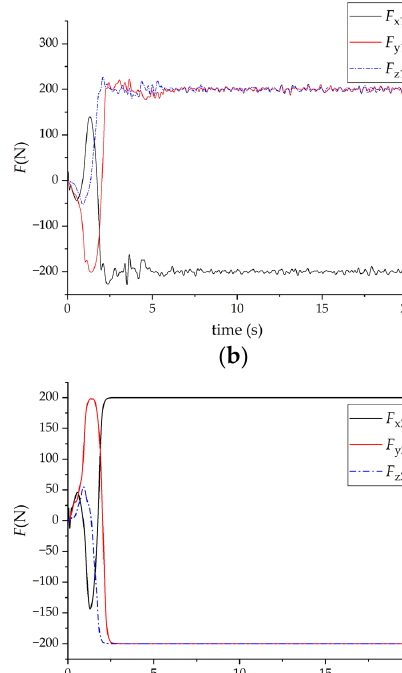
Figure 16. Pose of the VR handle and the virtual object in the first experiment: ( a ) the x component; ( b ) the y component; ( c ) the z component; ( d ) the φ component; ( e ) the θ component; and ( f ) the ψ component.